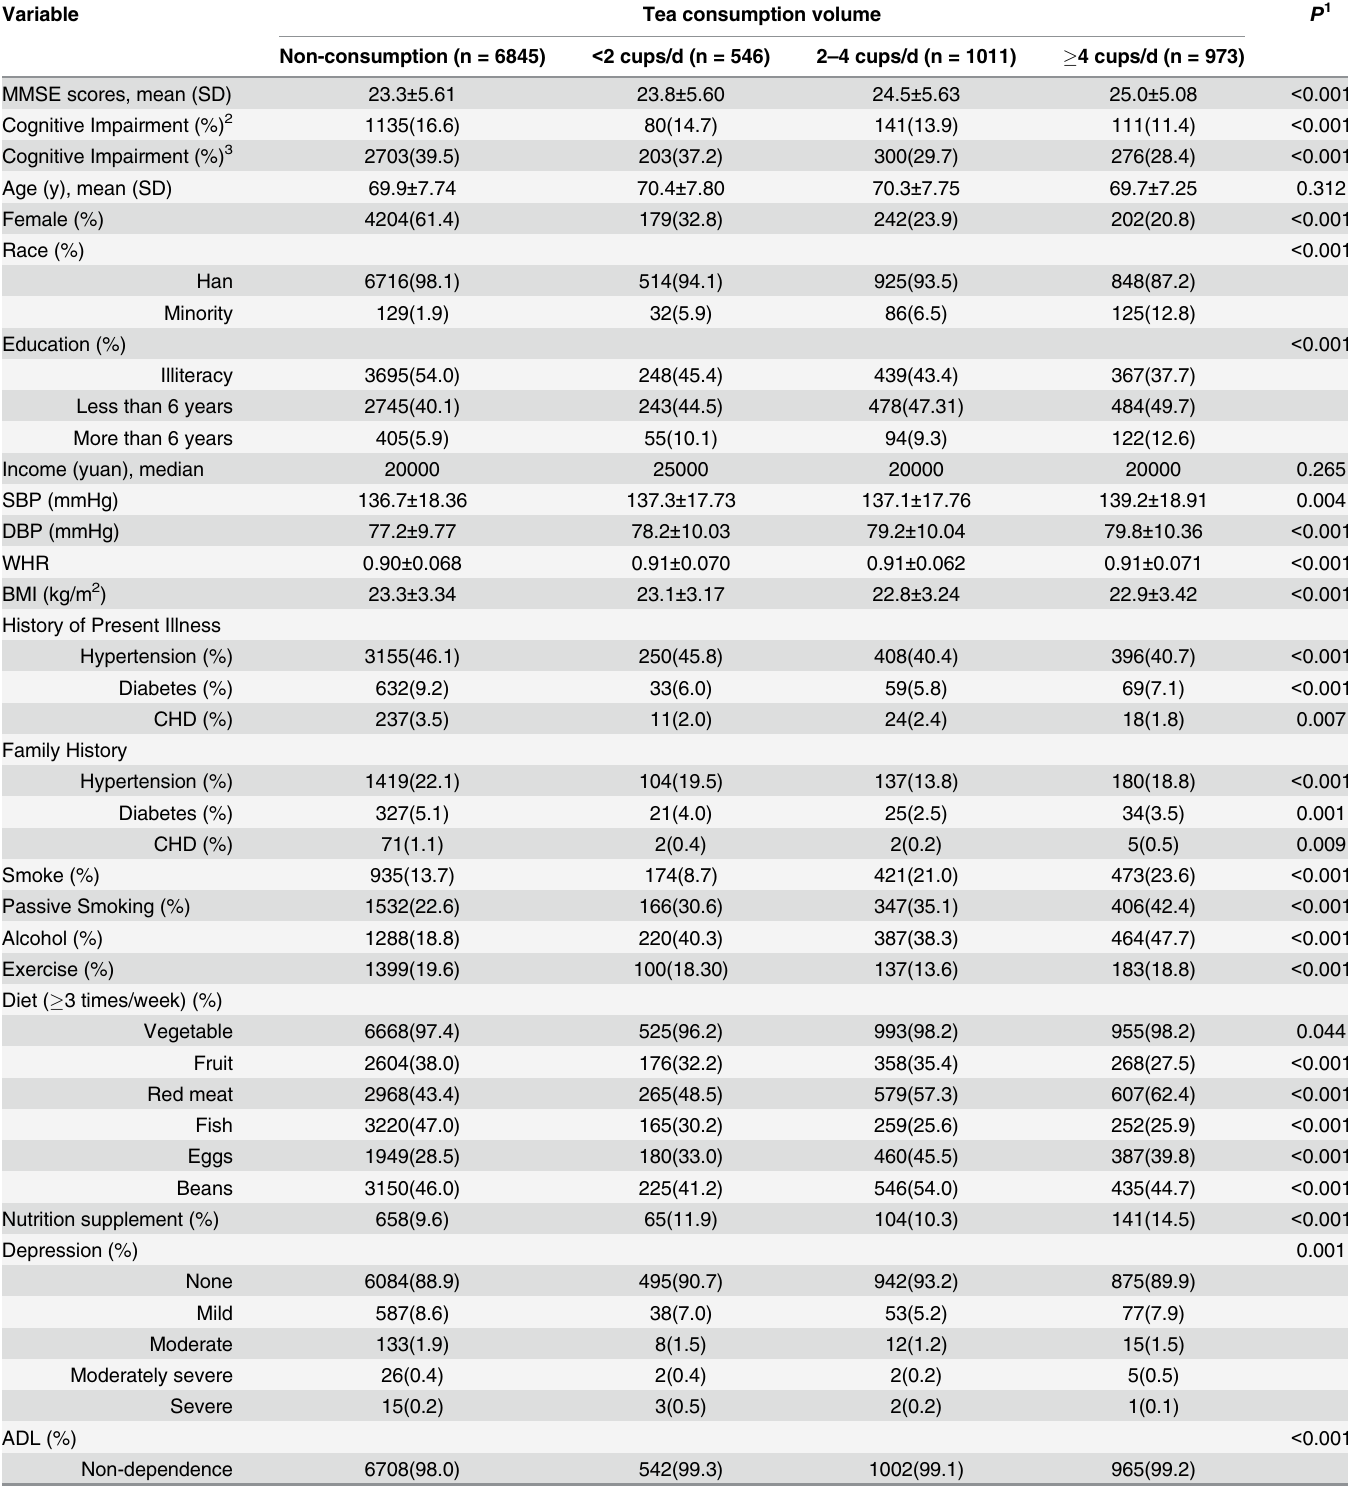
Table 2. Characteristics of study participants by volume of tea